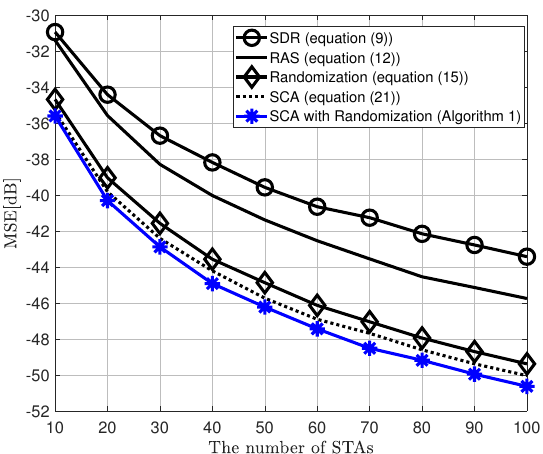
Figure 5. MSE performance of the proposed MIMO AirComp framework and other receive beamforming techniques, when SNR is 10 dB, objective function is arithmetic mean, and N T = 2, N R = 4.